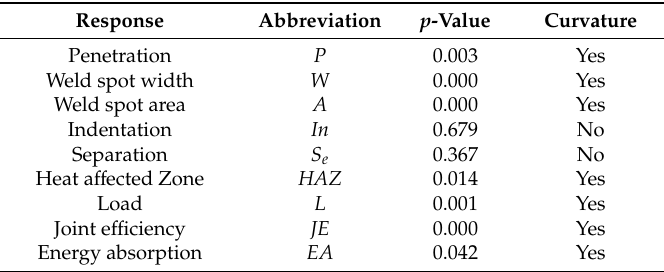
Table 10. Curvature analysis.